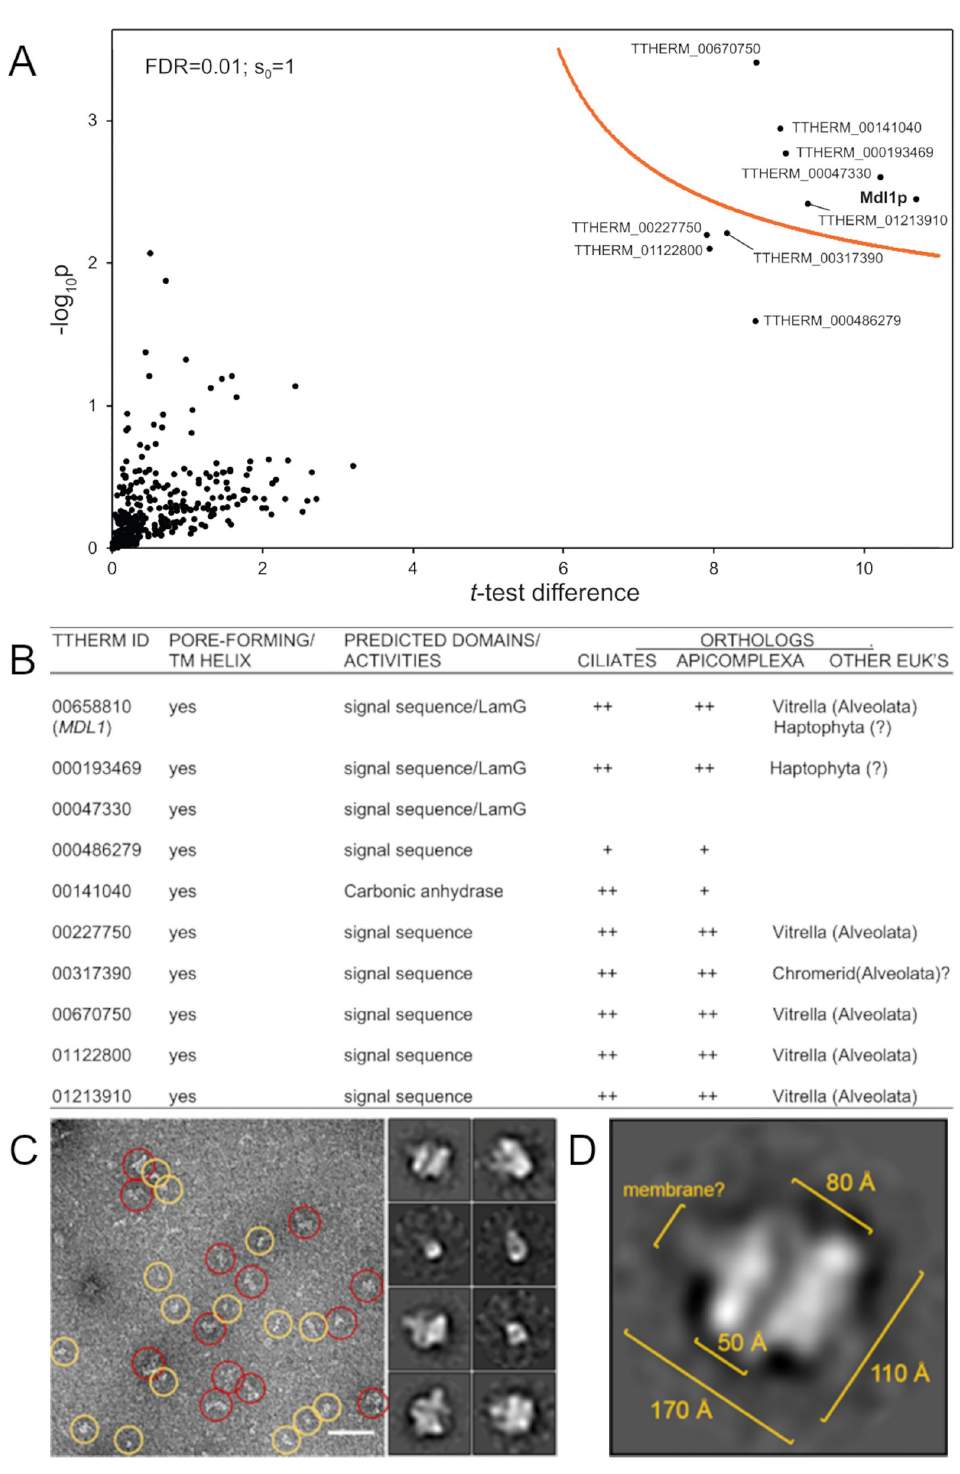
Fig 6. Identification and analysis of Mdl1p-interacting proteins. A. Volcano plot of mass spectrometry results, identifying the proteins associated with FLAG-tagged Mdl1p. Cryopowders from WT and Mdl1p-FLAG-expressing cells were solubilized and complexes immuno-isolated with anti-FLAG beads. Bound proteins were eluted with LDS sample buffer and run ~1cm into an SDS-PAGE gel. Individual gel lanes were excised and processed for mass spectrometric analysis. On Volcano plots such as the one shown here, proteins falling above the threshold line are